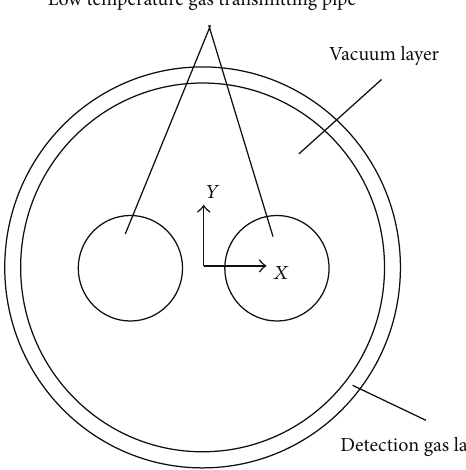
Figure 1: Cross section of the pipe.